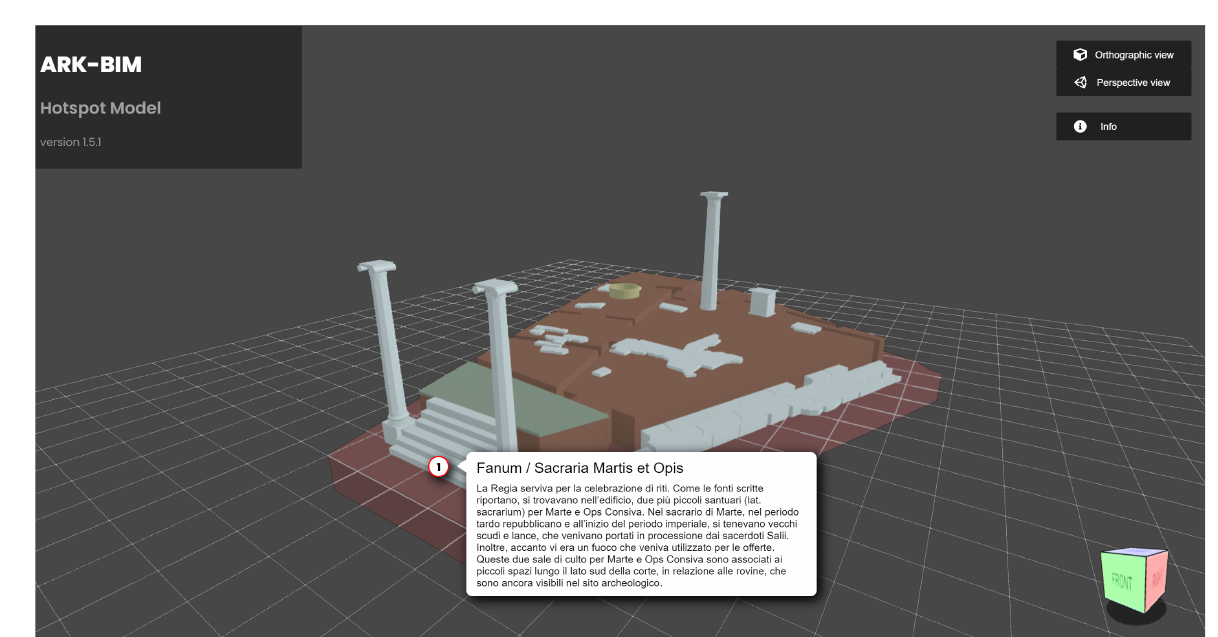
Figure 16. ARK-BIM (version 1.5.1): Hotspot Model plugin, sample with textual information.